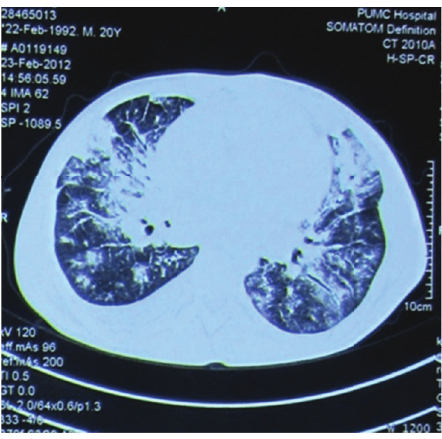
Figure 1: Chest CT. It shows bilateral patchy ground-glass opacities and subpleural nodules.